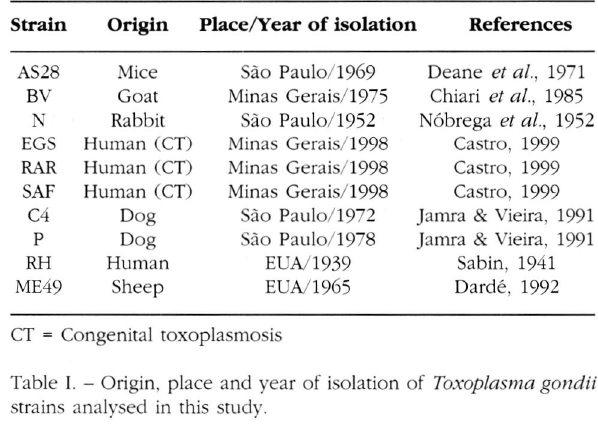
Table I. - Origin, place and year of isolation of Toxoplasma gondii strains analysed in this study.